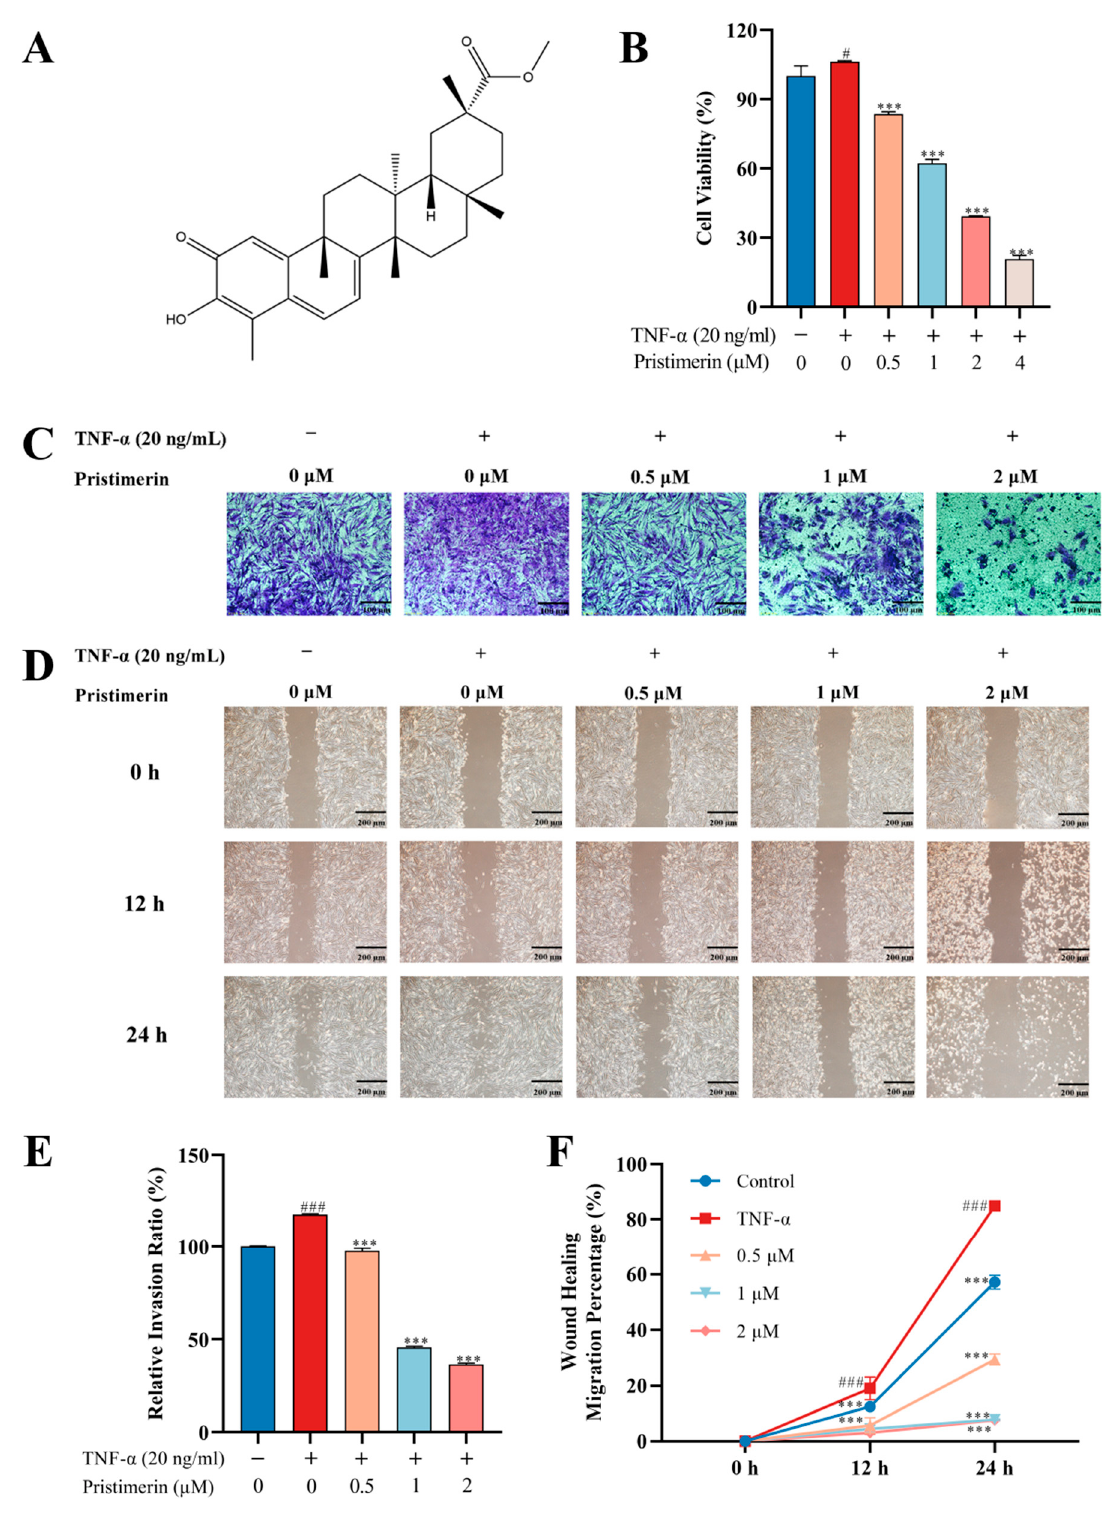
Figure 1. Effects of pristimerin on cell viability and migration. ( A ) Chemical structure of pristimerin; ( B ) MH7A cells were treated with pristimerin (0.5, 1, 2 µ M) on MH7A cells for 24 h. Cell viability was determined by MTT assay; ( C , E ) MH7A cells were incubated with pristimerin (0.5, 1 and 2 μ M) for 24 h. The migrated cells were stained with crystal violet and the relative cell migration was cal- culated. ( D , F ) For the wound healing assay, artificial wounds were created in MH7A cells, which